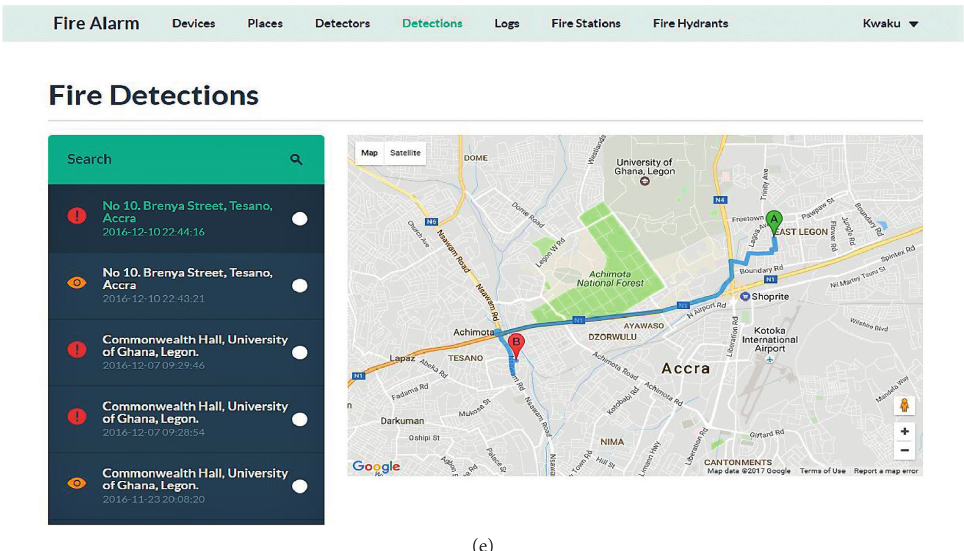
Figure 14: (a) Mobile application screenshots. (b) Web application home page. (c) Detector inventory. (d) Entity-relationship diagram. (e) Web application map navigation.